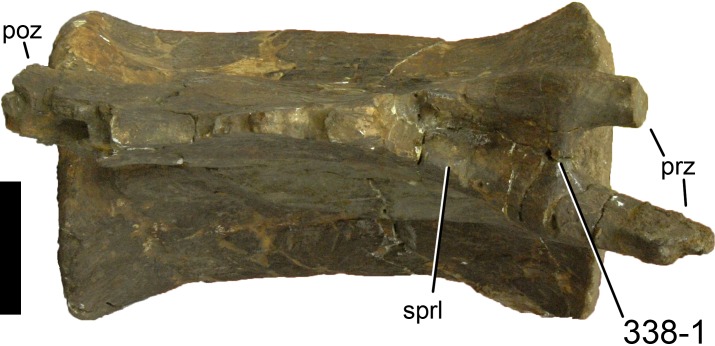
Mid-caudal vertebra of Diplodocus longus YPM 1920 in dorsal view.Note the transverse ridge connecting the prezygapophyses posteriorly (C338-1). Abb.: poz, postzygapophysis; prz, prezygapophysis; sprl, spinoprezygapophyseal lamina. Scale bar = 5 cm.